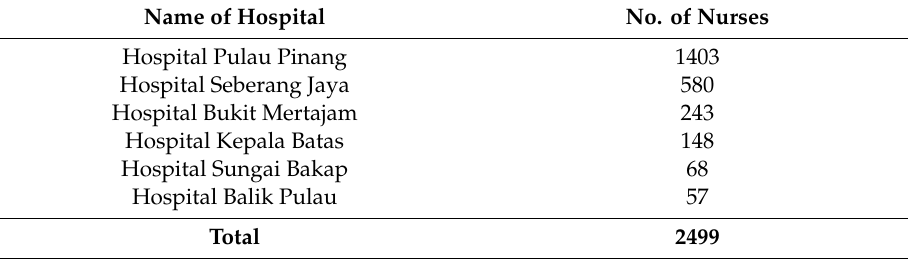
Table 1. List of nurses in the public hospitals of Penang, Malaysia (as of August